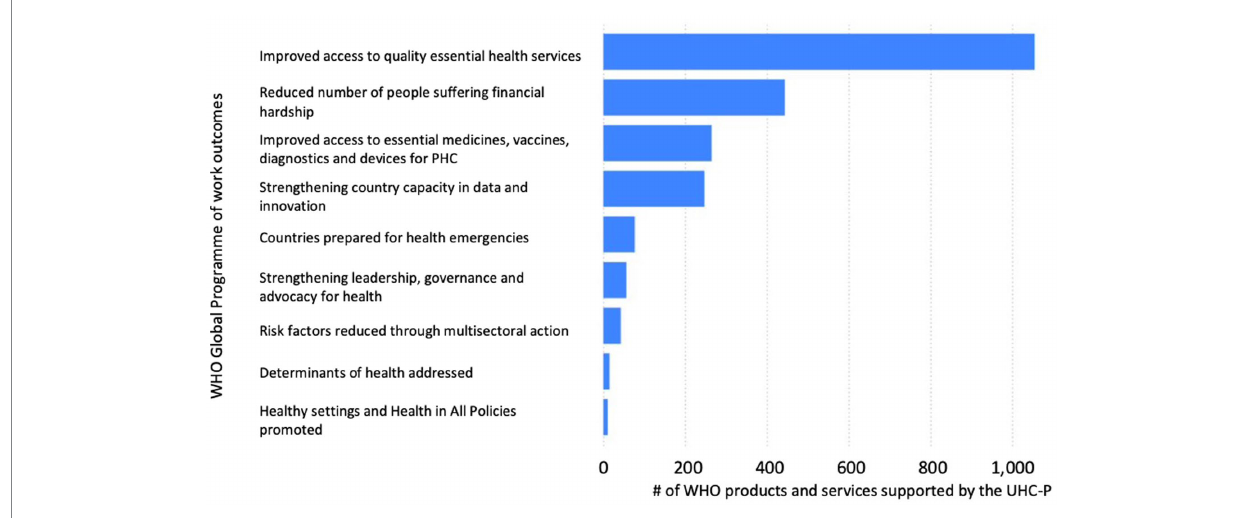
FIGURE 3 UHC Partnership support to the 13th WHO Global Programme of work,